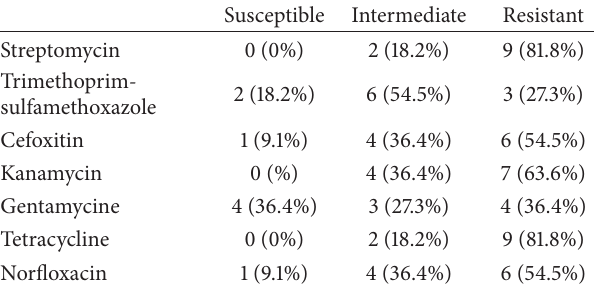
Table 3: Antimicrobial resistance profile of E. coli O157:O7